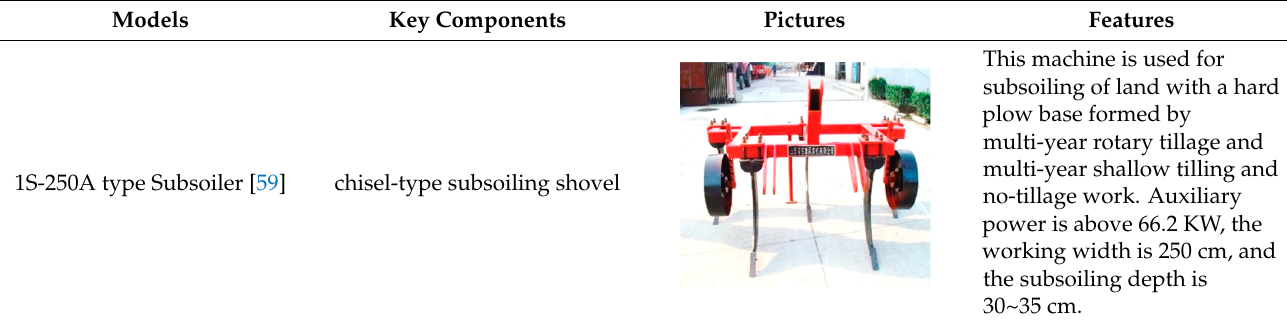
Table 4. Typical subsoilers and combined operation machines.